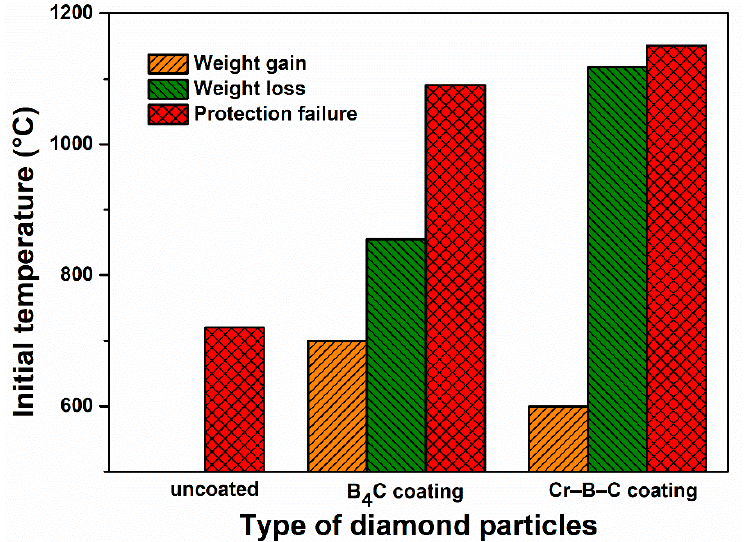
Figure 5. Initial temperature of the three types of diamond particles in TGA